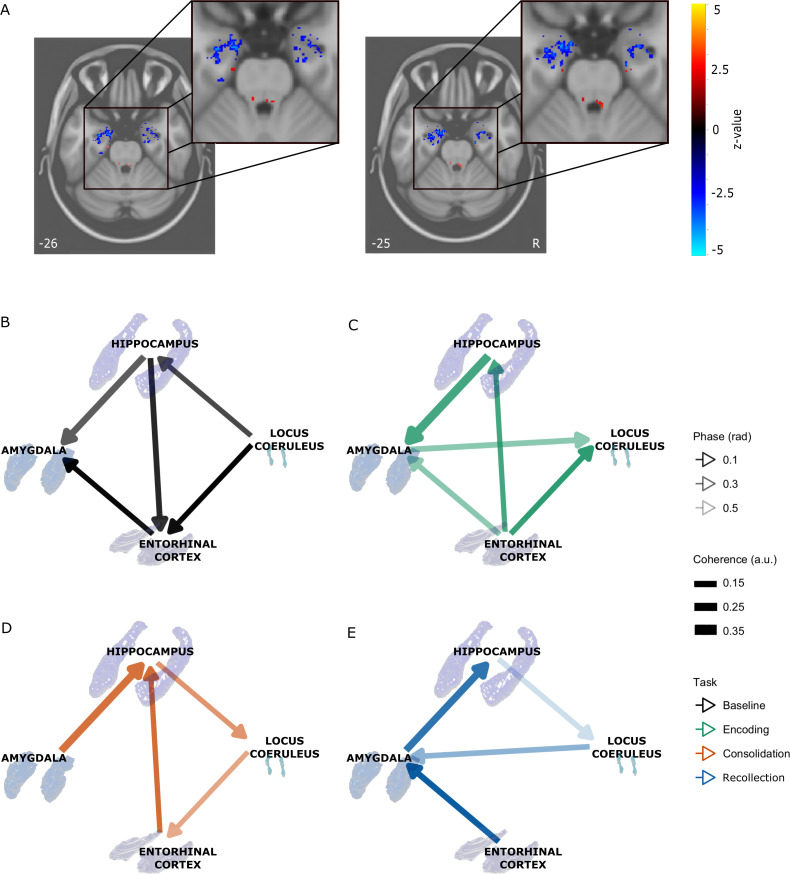
Integration of LC and MTL timeseries across the task (N = 24).(A) Functional connectivity (FC) from LC component to MTL structures across task stages. Clusters of decreased FC in hippocampus, amygdala and entorhinal cortex were observed comparing consolidation to baseline (p<0.05, uncorrected). (B-E) Median maximum coherence and phase across task stages between timeseries from the LC and the clusters from the hippocampus, amygdala and entorhinal cortex from the FC analysis (B: baseline resting-state; C: encoding; D: consolidation; E: recollection). Confidence intervals of maximum coherence were calculated per timeseries and the median maximum coherence and phase were extracted. The significant partial coherence (regressing out timeseries from other regions) is visualized. The thickness of the edges indicates the strength of coherence. The absolute phase difference between timeseries is shown in transparencies. Arrows indicate the direction of the phase lag from leading to lagging.Figure 7—source data 1.Coherence and phase between time series of the locus coeruleus and medial temporal lobe clusters.Individual coherence and phase values between the locus coeruleus and each cluster in the medial temporal lobe (amygdala, hippocampus, entorhinal cortex) are provided per task stage.